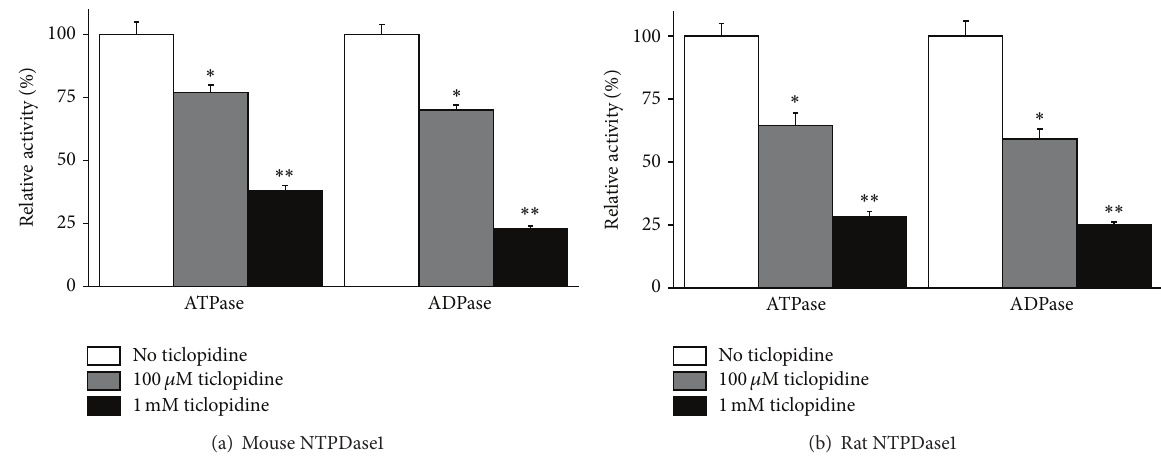
Figure 3: Comparative effect ofticlopidine on recombinant murineNTPDase1. ATPase and ADPase activity of mouse(a)or rat (b)NTPDase1 withoutandwitheither100 𝜇 Mor1mMticlopidinearepresented.The100%activitywithATPasthesubstrateintheabsenceofticlopidinewas ⋅ min −1 ⋅ mg protein −1 for mouse and rat NTPDase1, respectively, and with ADP 2219±105 and 1103±56 nmol 2781±136 and 1502±66 nmol P i P i ⋅ min −1 ⋅ mg protein −1 for mouse and rat NTPDase1, respectively. Data are presented as the mean ± SD of 3 experiments carried out in triplicate. ∗ 𝑃 = 0.0049 ; ∗∗ 𝑃 = 0.0007 .